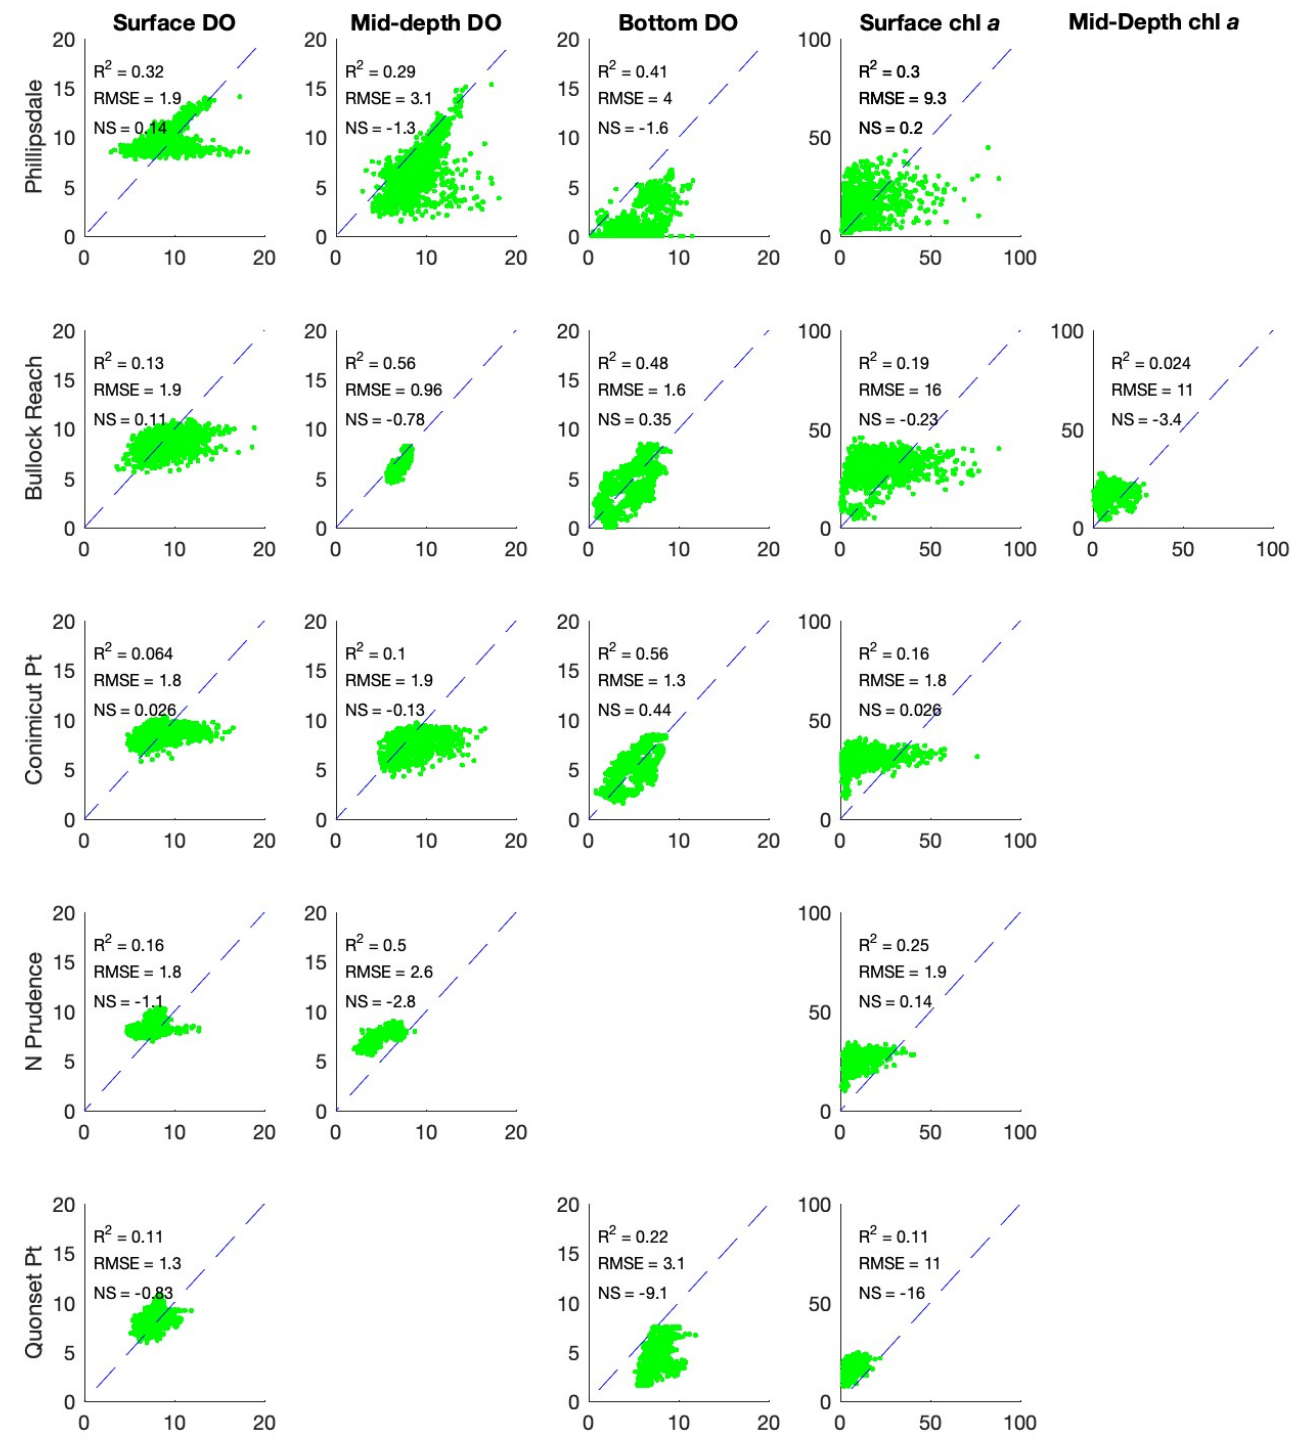
Figure 6. Simulated WASP vs. Observed Continuous Sonde Dissolved Oxygen and Phytoplankton Concentrations with Calculated R 2 , Root Mean Square Error (RMSE), and Nash–Sutcliffe (NS). Simulated WASP vs. Observed Sonde data. First 3 columns are DO at Surface, Mid-depth, and Bottom. Columns 4 and 5 are chl a at surface and mid-depth. Rows are locations from north to south.